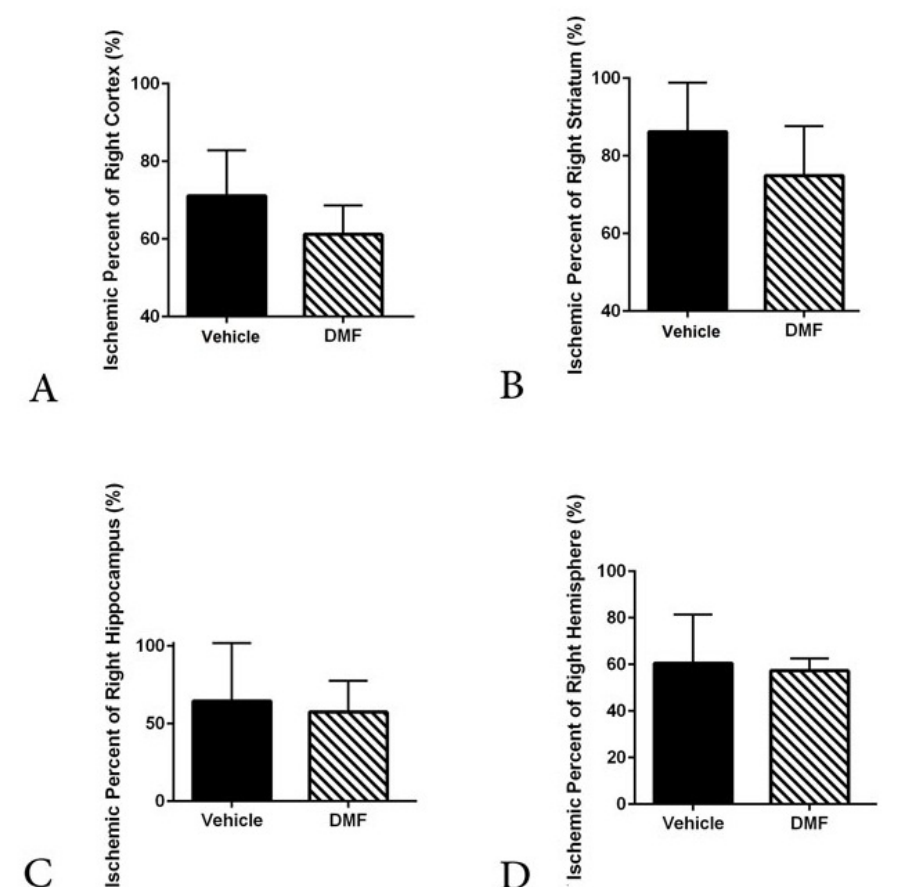
FIGURE 5 - Ischemic percent (mean ± SD) in the right cortex, striatum, hippocampus, and hemisphere in the vehicle and dimethyl fumarate (DMF) - treated